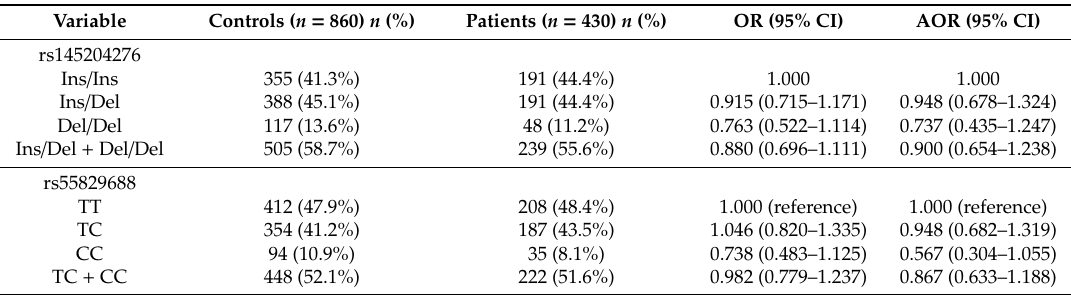
Table 2. Genotype distributions of GAS5 gene polymorphisms in 860 controls and 430 patients with